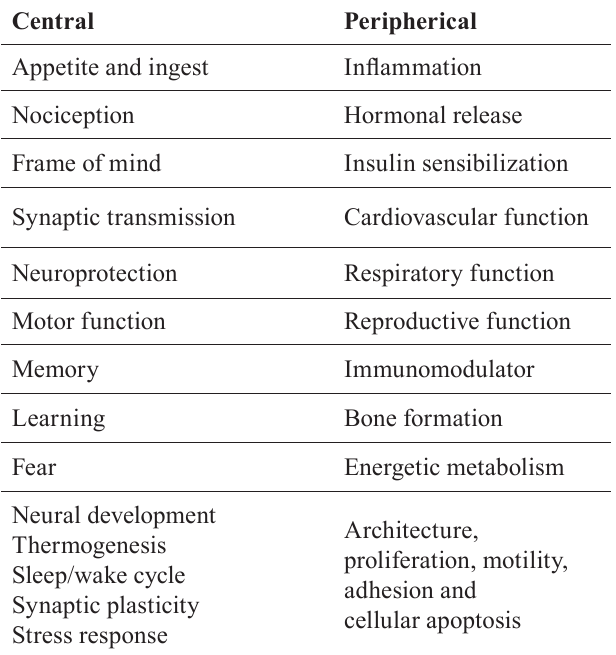
TABLE V - P hysiological processes in which the endocannabinoid system is participating (McPartland, Guy, Di Marzo, 2014; Nahtigal et al. , 2016; Pazos,